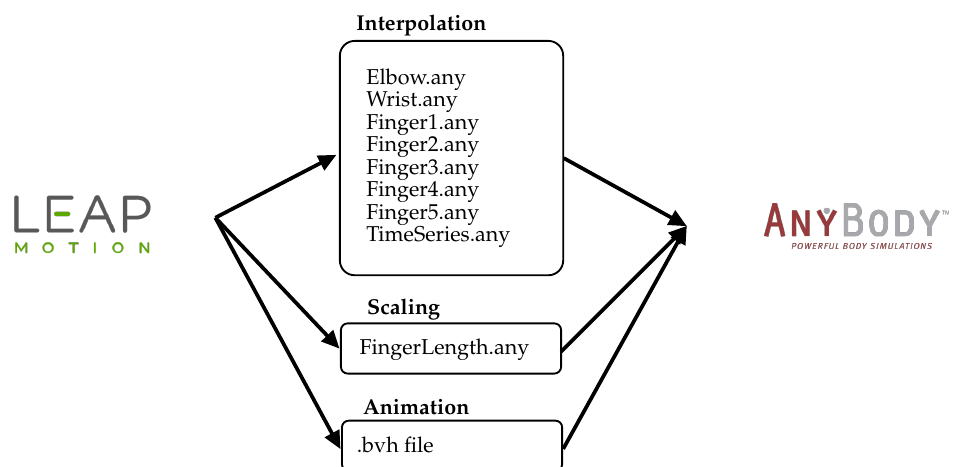
Figure 6. The transfer of data from the LMC to the AMS is divided into three categories. Interpolation: The angles of all joints of the fingers: 1—thumb, 2—index, 3—middle, 4—ring, and 5—pinky, as well as for the wrist and the elbow are stored in vector files. In each file up to three vectors are stored for each joint in order to fully represent the movement in a joint: flexion/extension, abduction/adduction, and rotation. Scaling: The positions of the joints are used to calculate the lengths of the fingers, which are transmitted via the file ( FingerLength.any ). Animation: The complete movement is stored in a BVH motion file. This serves to restore the recording and visualize the movement. (Source: Leap Motion logo [28] and AnyBody logo